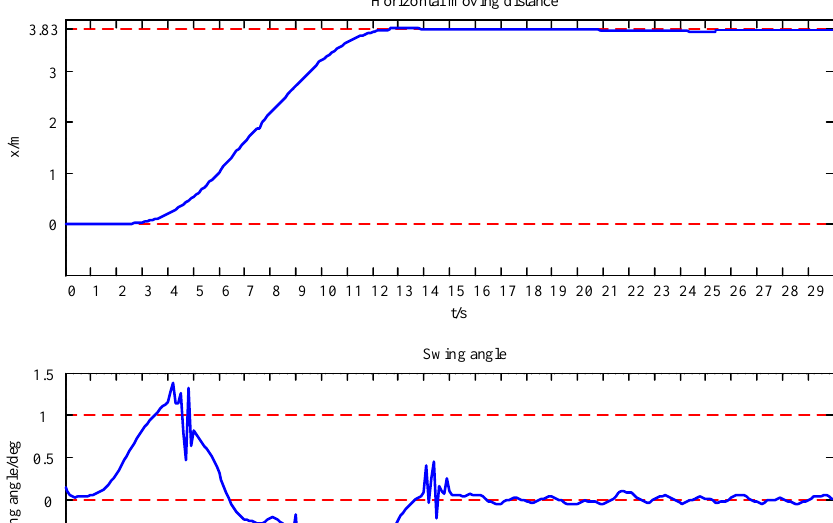
Figure 10. Result of experiment 1.